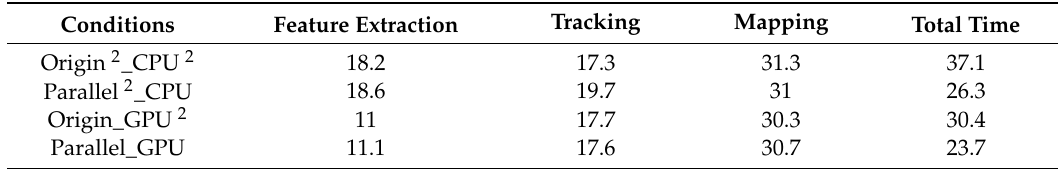
Table 4. Runtime (ms) performance of VINS-MKF with different feature extraction conditions on static dataset.